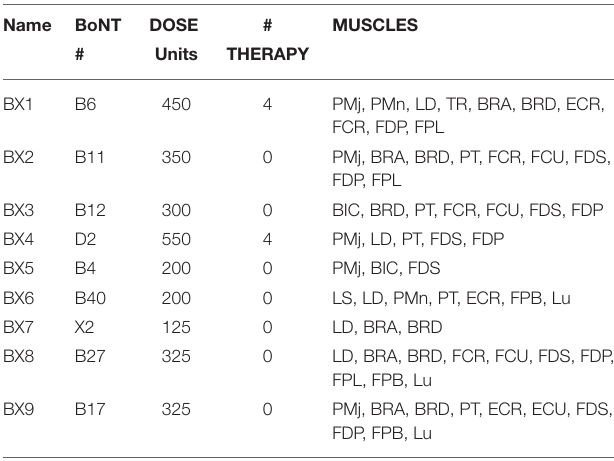
Table listing the BoNT dosage and physical therapy sessions for each stroke participant. # Therapy, therapy sessions between BoNT-A treatments; BoNT B, Botox (OnabotulinumtoxinA); D, Dysport (AbobotulinumtoxinA); X, Xeomin (IncobotulinumtoxinA); PMj, Pect Major; PMn, Pect Minor; LD, Latissimus Dorsi; LS, Levator scap; TR, Tricaps; BRA, Brachialis; BRD, Brachioradialis; PT, Pron Teres; Lu-Lumbricals; FCU, Flexor Carpi Ulnaris; FPB, Flexor Pollicis Brevis; BIC, Biceps Brachii; FDS, Flexor Digitorum Superficialis; FPL, Flexor Pollicis Longus; FCR, Flexor Carpi Radialis; ECR, Extensor Carpi Radialis.